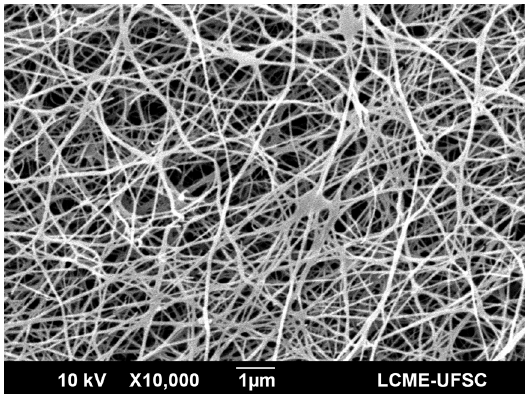
Figure 7. Micrography obtained by scanning electron microscopy of the upper side of neat BC membrane.